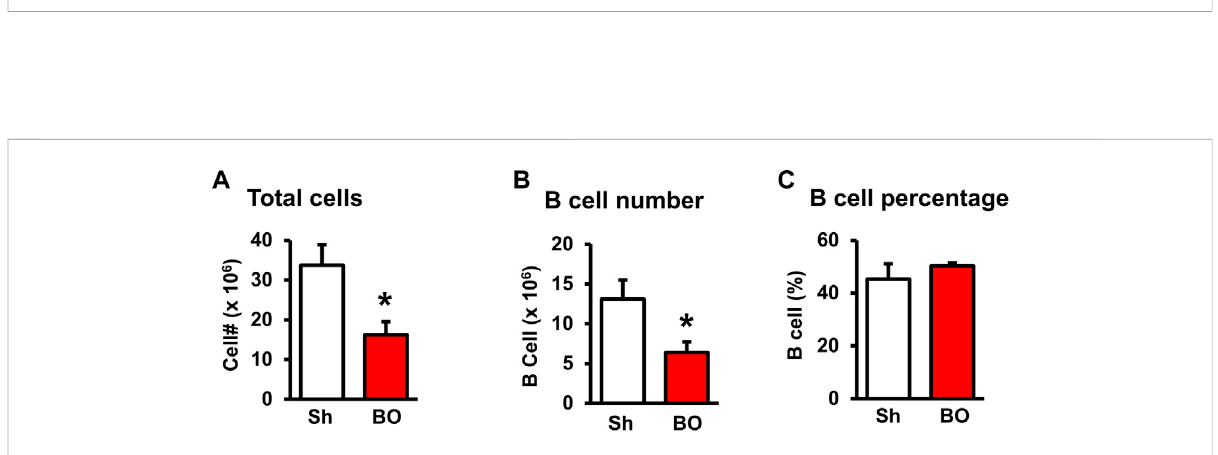
FIGURE 4 Effect of bowel obstructionon thebone marrow. (A) Total cells from sham rats (Sh) and rats with bowel obstruction for 7 days. (B) Number of B lymphocytes (CD45RA + ). (C) Percentage of B lymphocytes (CD45RA + )among total lymphocytes. N = 5 or 6 per group. * p < 0.05 vs. sham. Sh, sham. BO, bowel